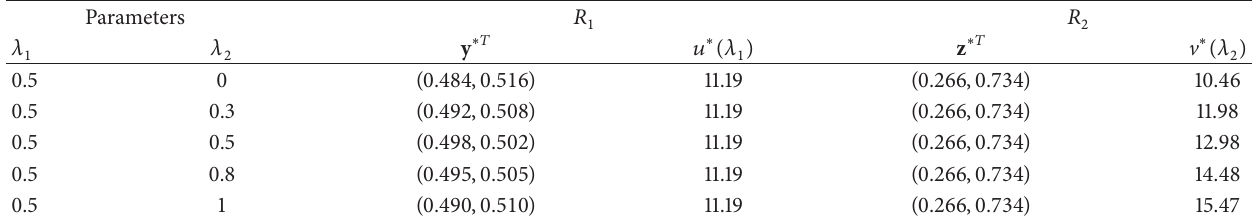
Table 2: Satisfying Nash equilibrium values and corresponding strategies of commerce